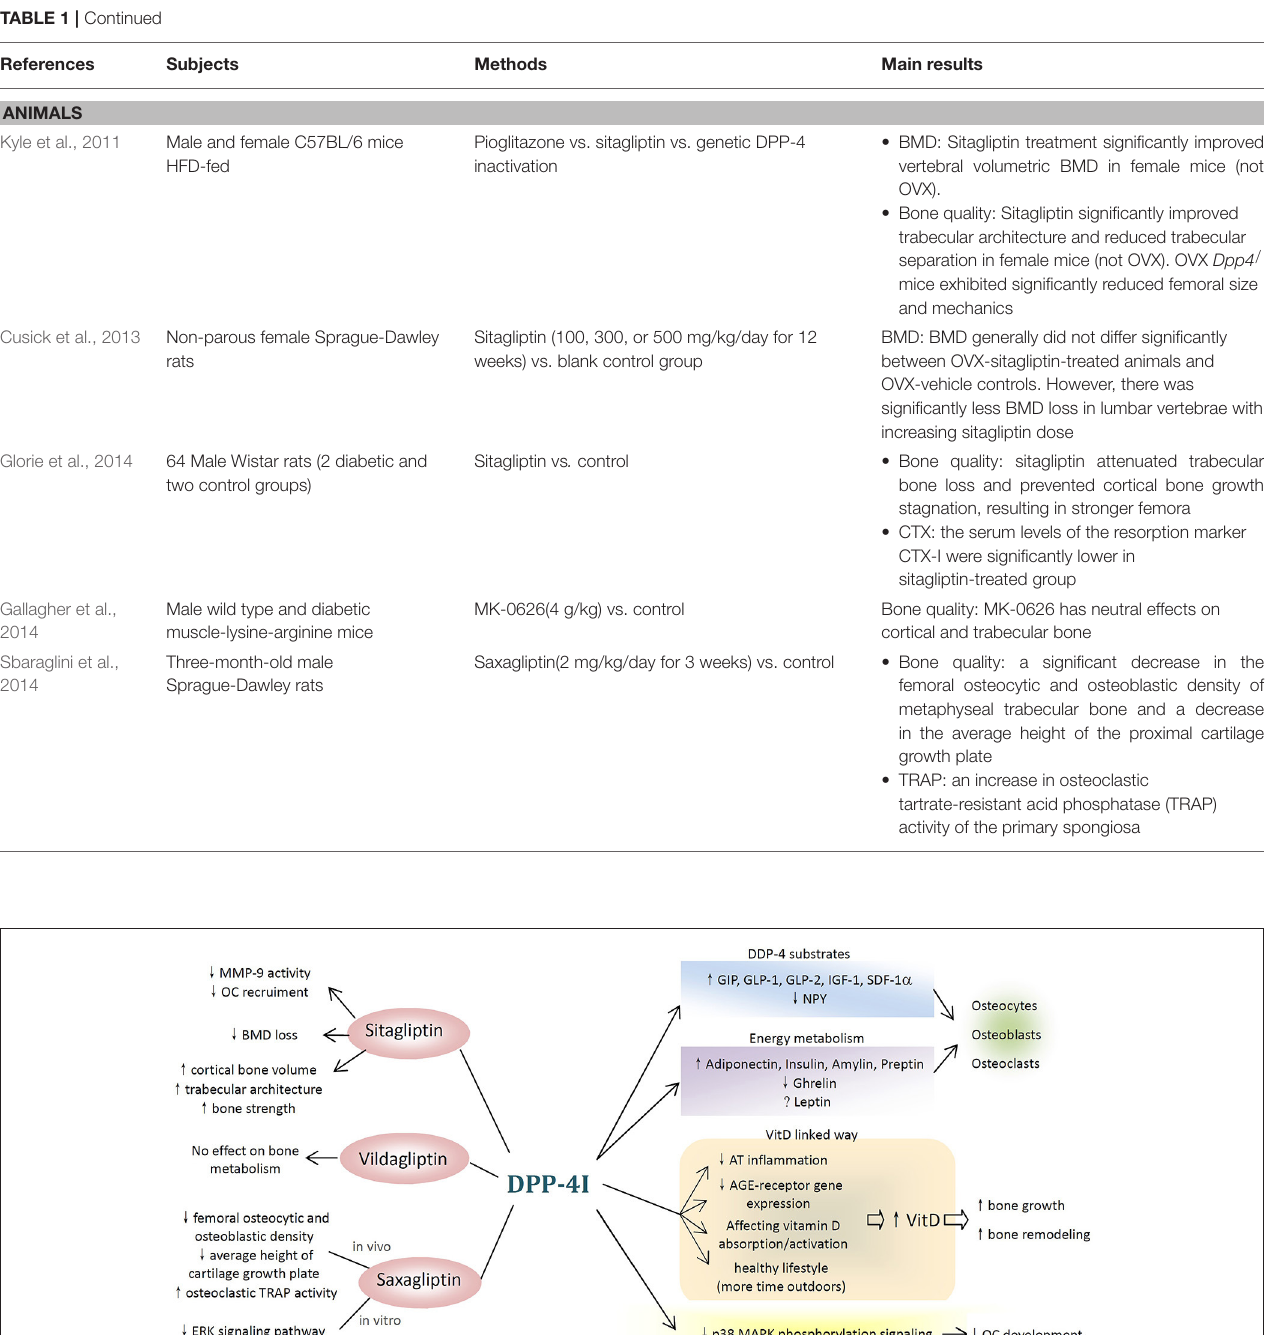
Frontiers in Pharmacology |